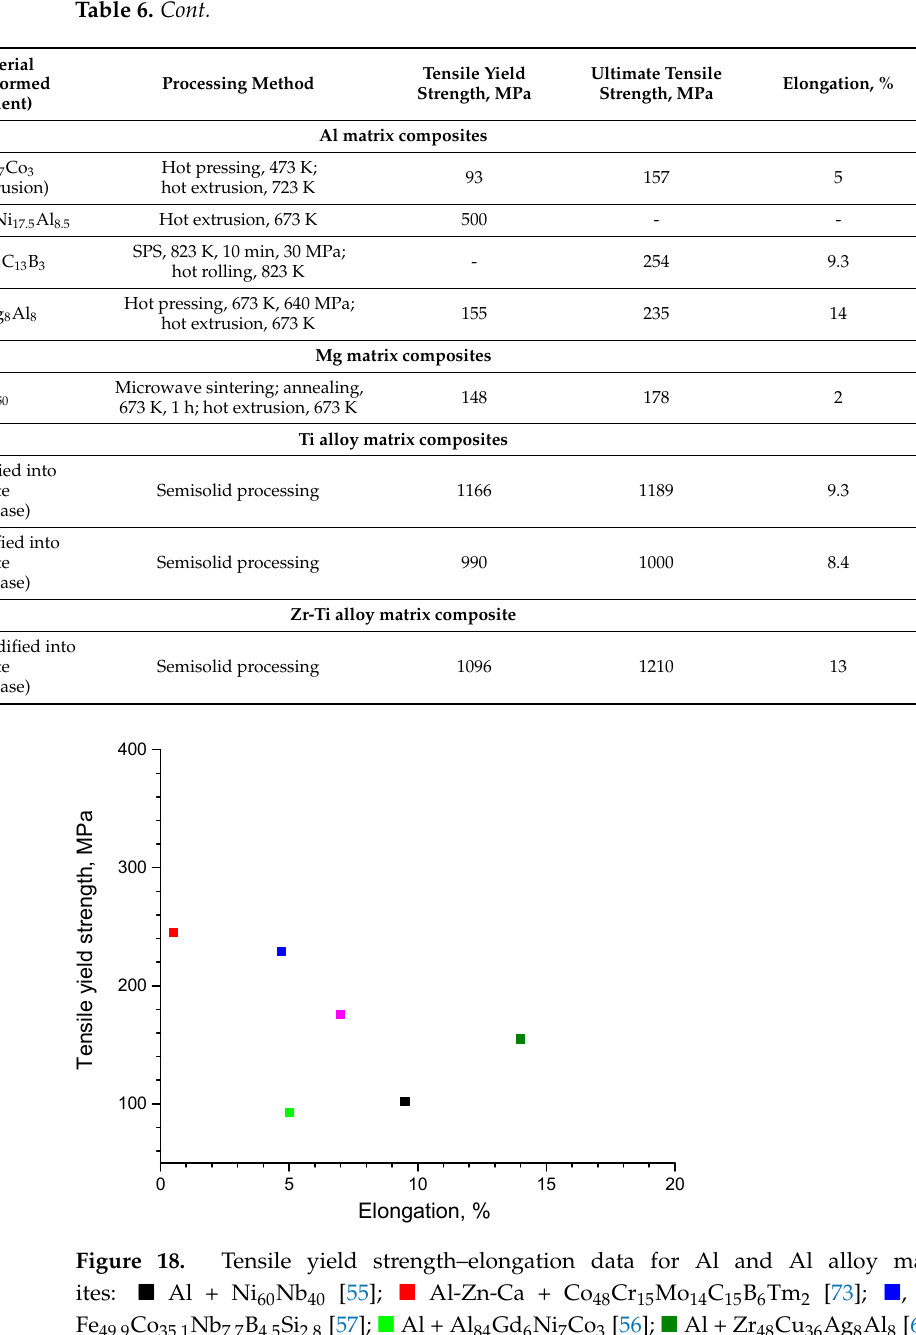
The metallic glass-reinforced Al matrix composites showed remarkably improved wear resistance relative to that of the unreinforced matrix when subjected to abrasive pin-on-disc tests [52]. The abrasive wear rate decreased from 2.46 × 10 − 4 m 3 /m for the Al 6061 extruded alloy to 0.373 × 10 − 4 m 3 /m for the composite containing 50 vol.% of the glass. Plowing was found to be the dominant mechanism of wear of the unreinforced alloy. The addition of a glassy reinforcement with higher hardness than the matrix material reduced the interaction between the hard abrasive particles and the soft matrix, which resulted in diminished groove formation, as indicated by lower surface